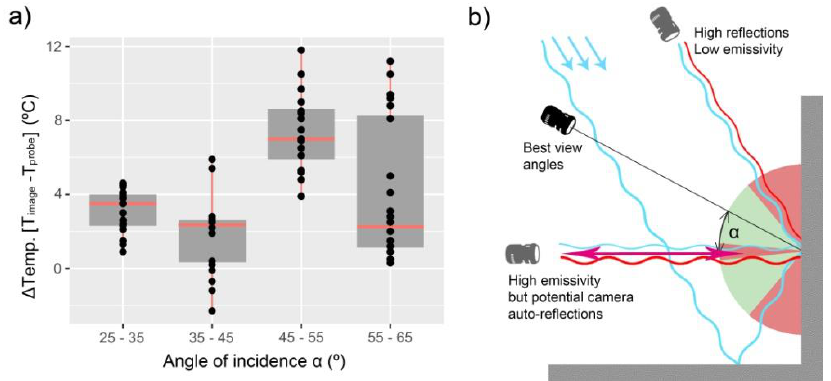
Figure 9. Influence of the angle of incidence on radiometry: The box plot ( a ) shows the differences between image-based ST values and contact measurements (PT 56C) vs. the angle of view, and the sketch ( b ) represents the thermal emission and disturbances due to reflections.